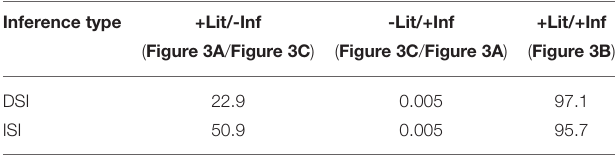
TABLE 1 | Target choice rates in % by